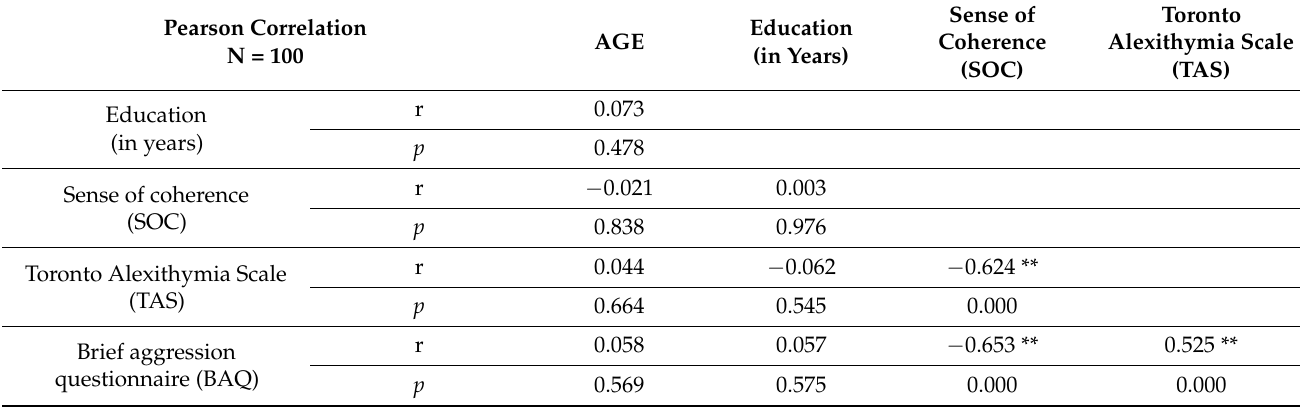
Table 2. Correlations among age, education (in years), TAS, BAQ and SOC.